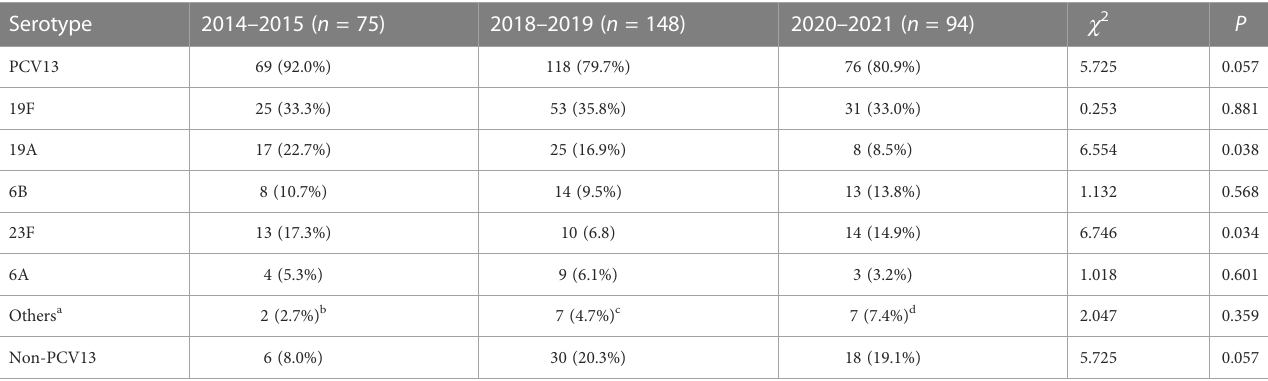
TABLE 1 Distribution of serotypes of S. pneumoniae strains isolated from different year periods. Serotype